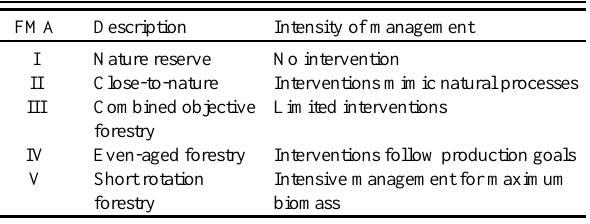
Table 1 . Description of forest management approaches (FMAs), following Duncker et al.